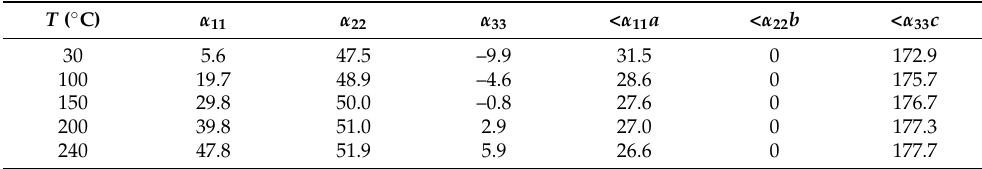
Figure 11. Crystal structure of SM , projections along [001] ( a ) and [100] ( c ); the respective arrangement of the figures of thermal expansion/contraction coefficients (TECs) in the structure of SM ( b , d ). Large red sphere at the center of the unit cell’s edge corresponds to the hypothetical site of H 2 O molecule, arranged in the center of the channel (see Section 3.2 for details). Legend: same as that in Figure 6; figures of TEC: expansion = blue and grey fill, contraction = red fill. Table 3. The main coefficients of the thermal expansion/contraction α ii ( i = 1–3) × 10 6 ◦ C − 1 and orientation of the main axes in the structure of SM